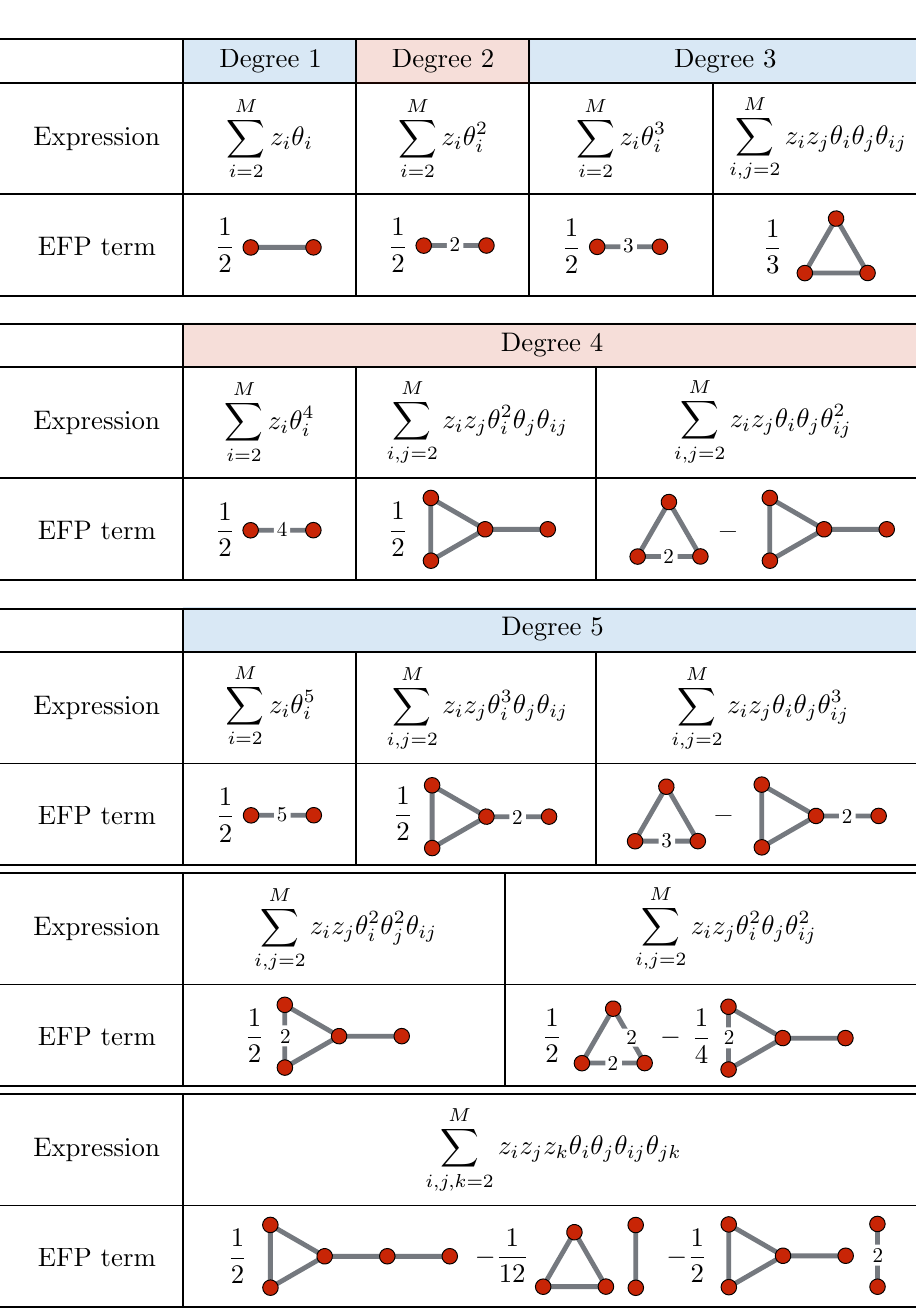
Table 4. Possible monomial structures that can appear in an EFP in the 1-collinear approximation up to degree 5, and the corresponding EFPs in terms of which they can be